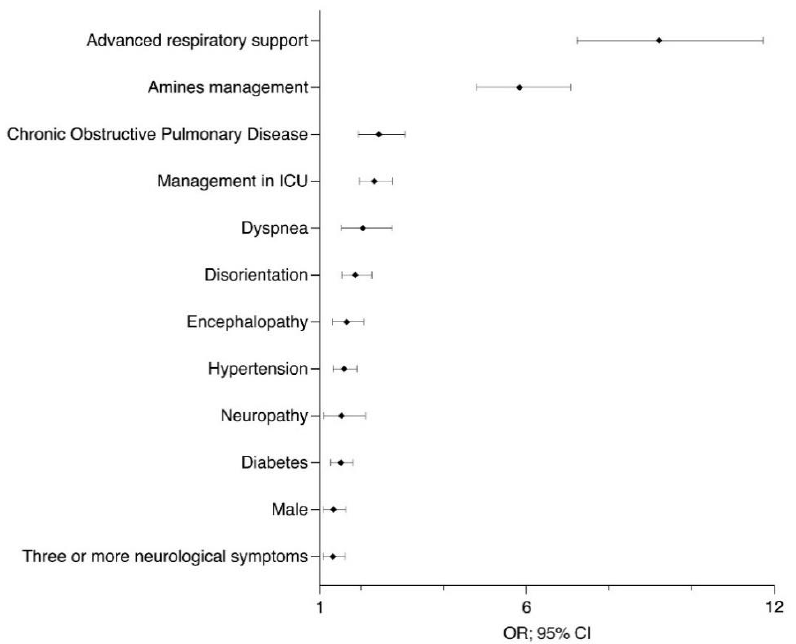
Figure 2. Factors associated with death. ICU: intensive care unit; OR: odds ratio; CI: confidence